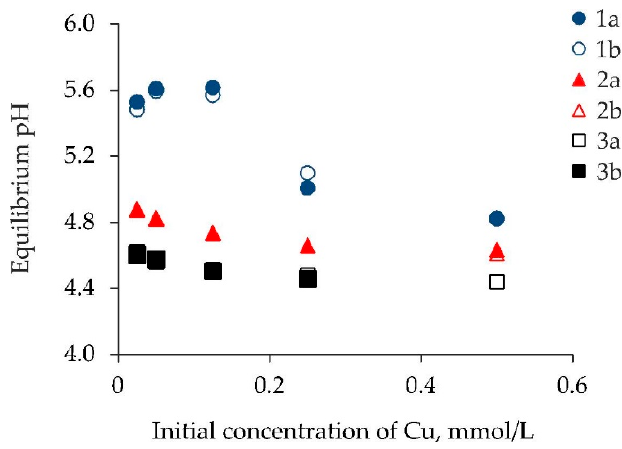
Figure 5. The dependence of the equilibrium pH value on the initial concentration of Cu(II). 1, 2, 3 = Na-, HAl 13 - and Al 13 -bentonite, respectively. Empty and filled icons—repetition of the experiment.